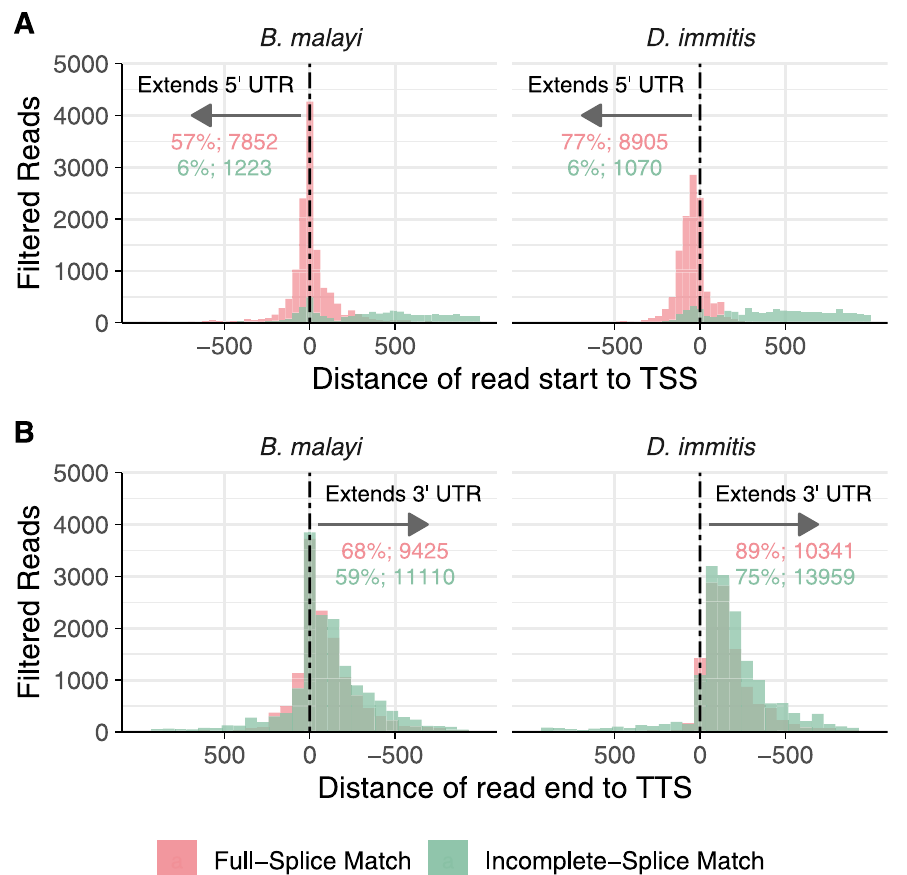
Fig 3. Iso-Seq extends UTRs of known transcripts. Filtered reads categorized as full or incomplete-splice matches (ISM) were examined for whether they extended the 5’ and 3’ untranslated regions. (A) A high portion of full-splice match (FSM) reads extend the annotated 5’ UTRs of known transcripts in both B . malayi (left) and D . immitis (right), while ISM reads rarely cover the 5’ end. (B) Both FSM and ISM reads extend the 3’ UTRs of known transcripts. Negative values indicate reads that cover the transcriptional start or termination sites. Percentages and values printed on the plot represent the percentage and number of total reads in that category that extend the given UTR. TSS: transcriptional start site. TTS: transcriptional termination